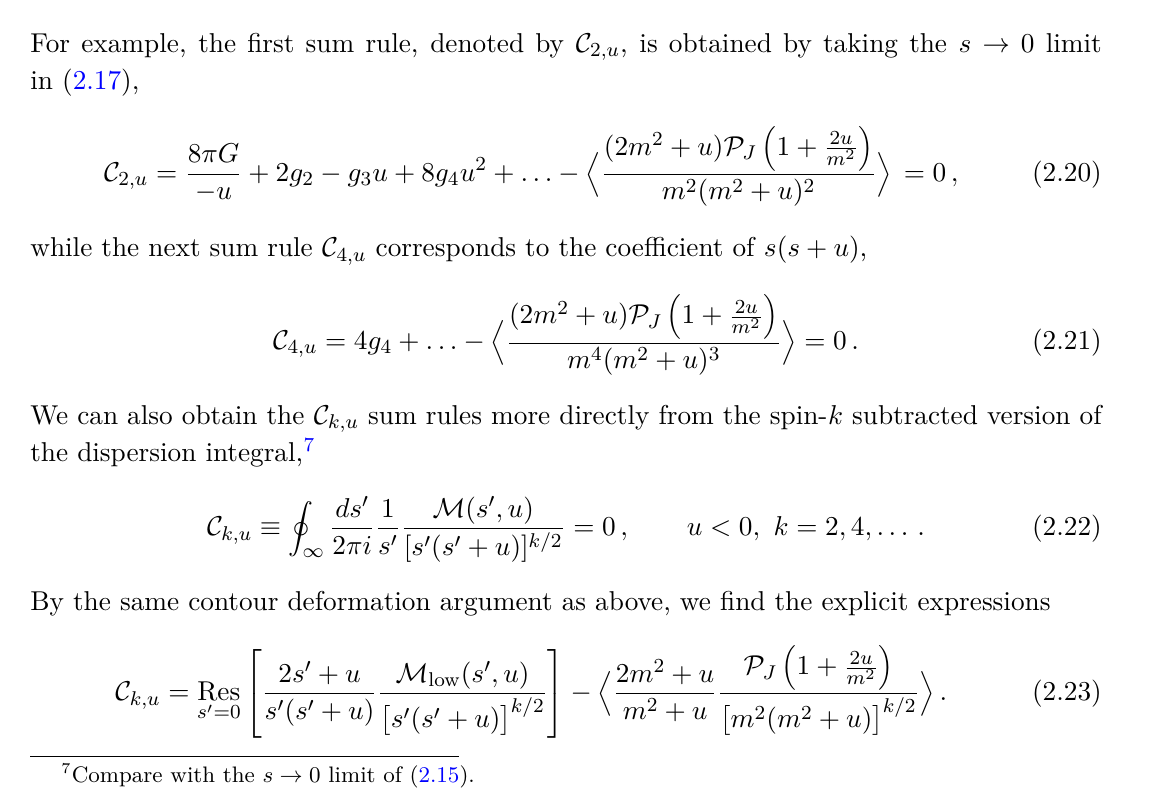
Figure 2 . Contour deformation leading to the dispersive sum rule (2.16). We start from an integral over a large circle (2.15), which vanishes due to the spin-2 boundedness assumption (2.14). After the contour deformation, we end up with an IR contribution, represented by the small circle on the right, and a UV contribution, represented by an integral over the cuts starting at s 0 = M 2 , − M 2 − u . In the presence of EFT loops, the IR contribution would also include cuts stretching between s 0 = − M 2 − u and s 0 = M 2 , but these are subleading under our assumptions. Since the theory is assumed weakly coupled at scale M , the heavy cut is well approximated by a discrete set of poles for s 0 not much larger than M 2 . However, this will play no role in our